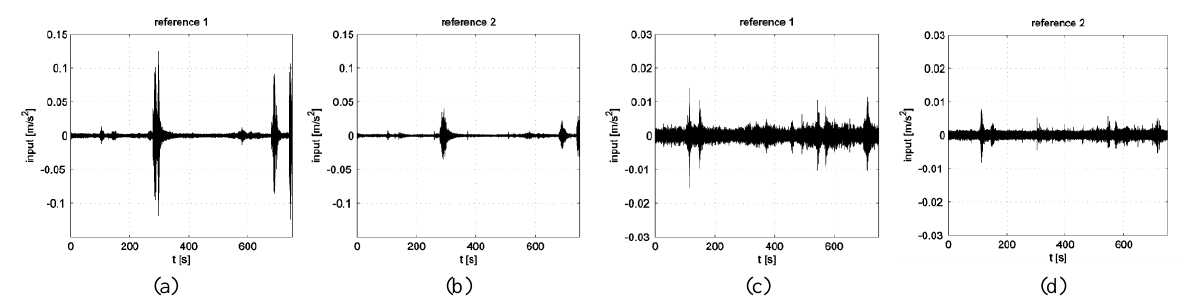
Fig. 4. On the reference nodes there are two characteristic types of natural excitation on the bridge. (a) pedestrian excitation reference 1; (b) pedestrian excitation reference 2; (c) wind excitation reference 1; (d) wind excitation reference 2.